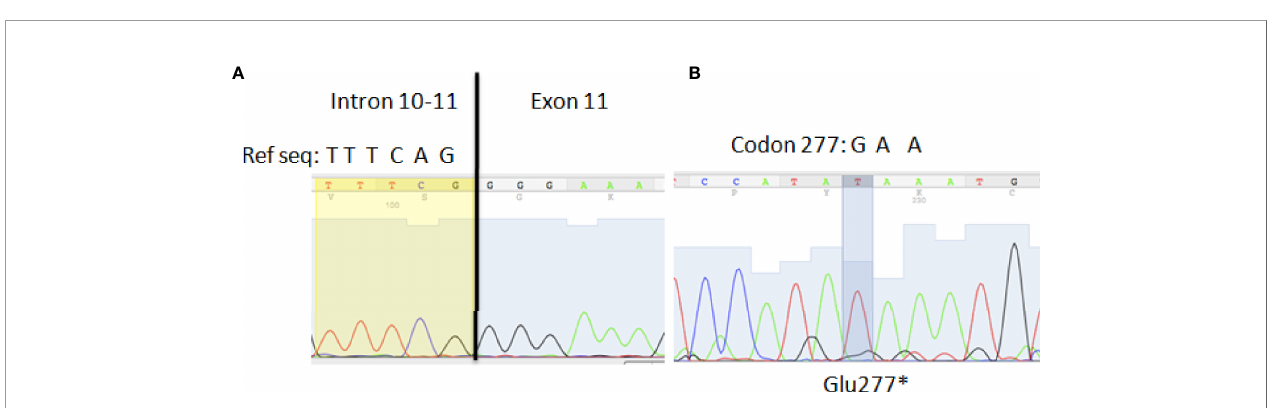
FIGURE 4 | (A) Splice site mutation in exon 11 as the cause of the exon 11 deletion reported in Lopez-Herrera G et al., 2014. A single nucleotide deletion was identi fi ed in the 5 ’ splice site: TTTCAG>TTTCG. (B) Missense transversion (G>T) in BTK cDNA causing a premature stop codon at position 277.